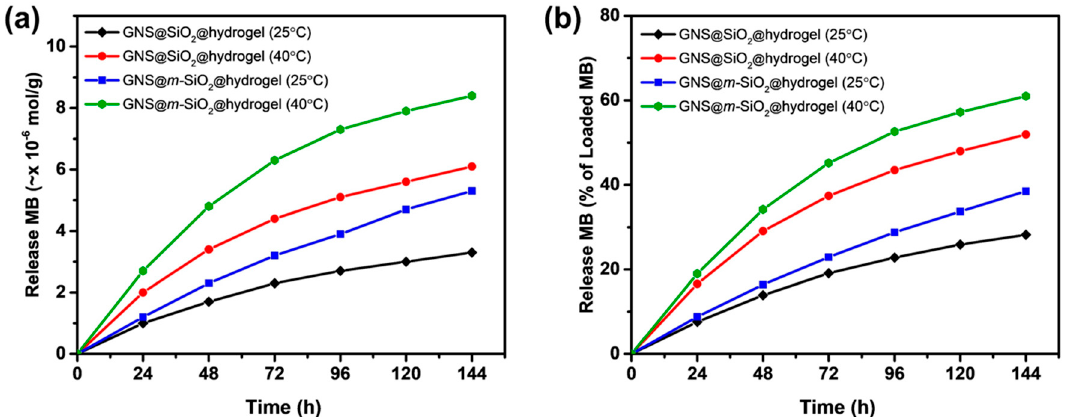
Figure 4. Release profiles of MB-loaded hydrogel-encapsulated composite NPs at constant temperatures of 25 °C and 40 °C; ( a ) released MB in terms of concentration (~× 10 − 6 mol/g) and ( b ) released MB percentage as compared to the loaded MB from hydrogel-encapsulated composite NPs.